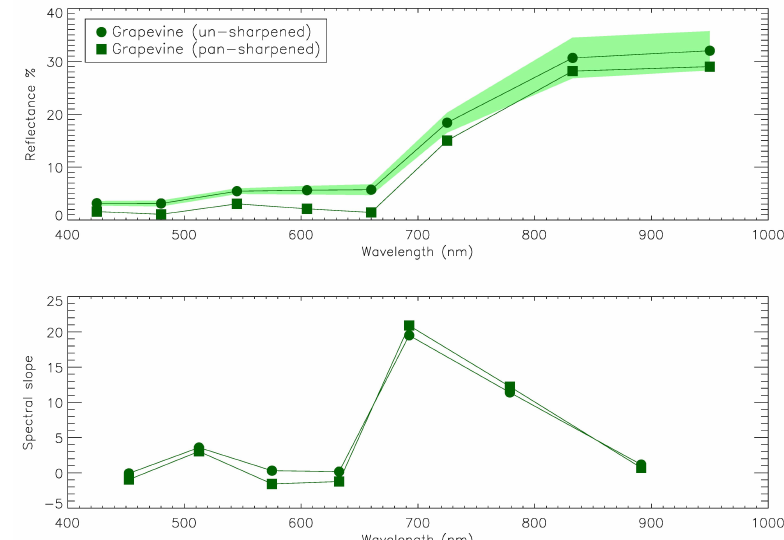
Figure 1. Comparison between the spectral profile ( top ) and spectral slopes ( bottom ) of a vinerow in both native resolution and pan-sharpened multispectral data. The green shaded region in the top plot gives the one standard deviation envelope around the mean un-sharpened reflectance values. The pan-sharpened spectral profile was calculated from 895 pixels within Image 4 (ideal viewing